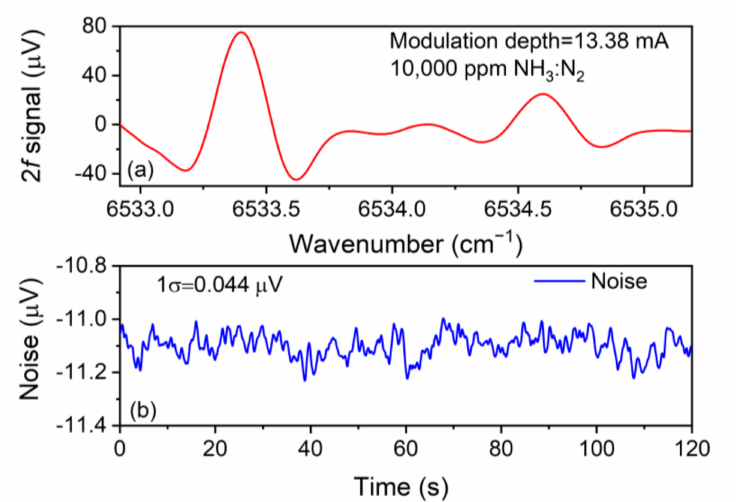
Figure 7. ( a ) 2 f signal of 10,000 ppm NH 3 :N 2 ; ( b ) noise level of NH 3 -LITES sensor.